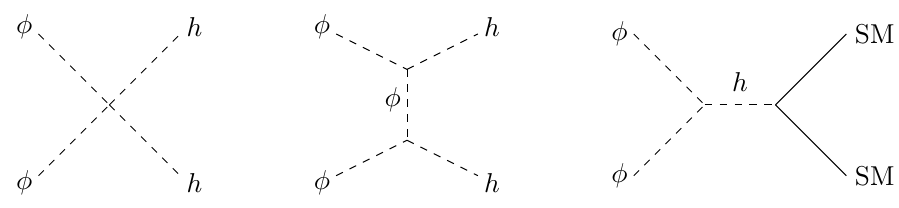
Figure 4 . Annihilation processes of real scalar singlet DM ( (cid:30) ) to SM particles. SM in the last graph stands for W (cid:6) ; Z; h and SM